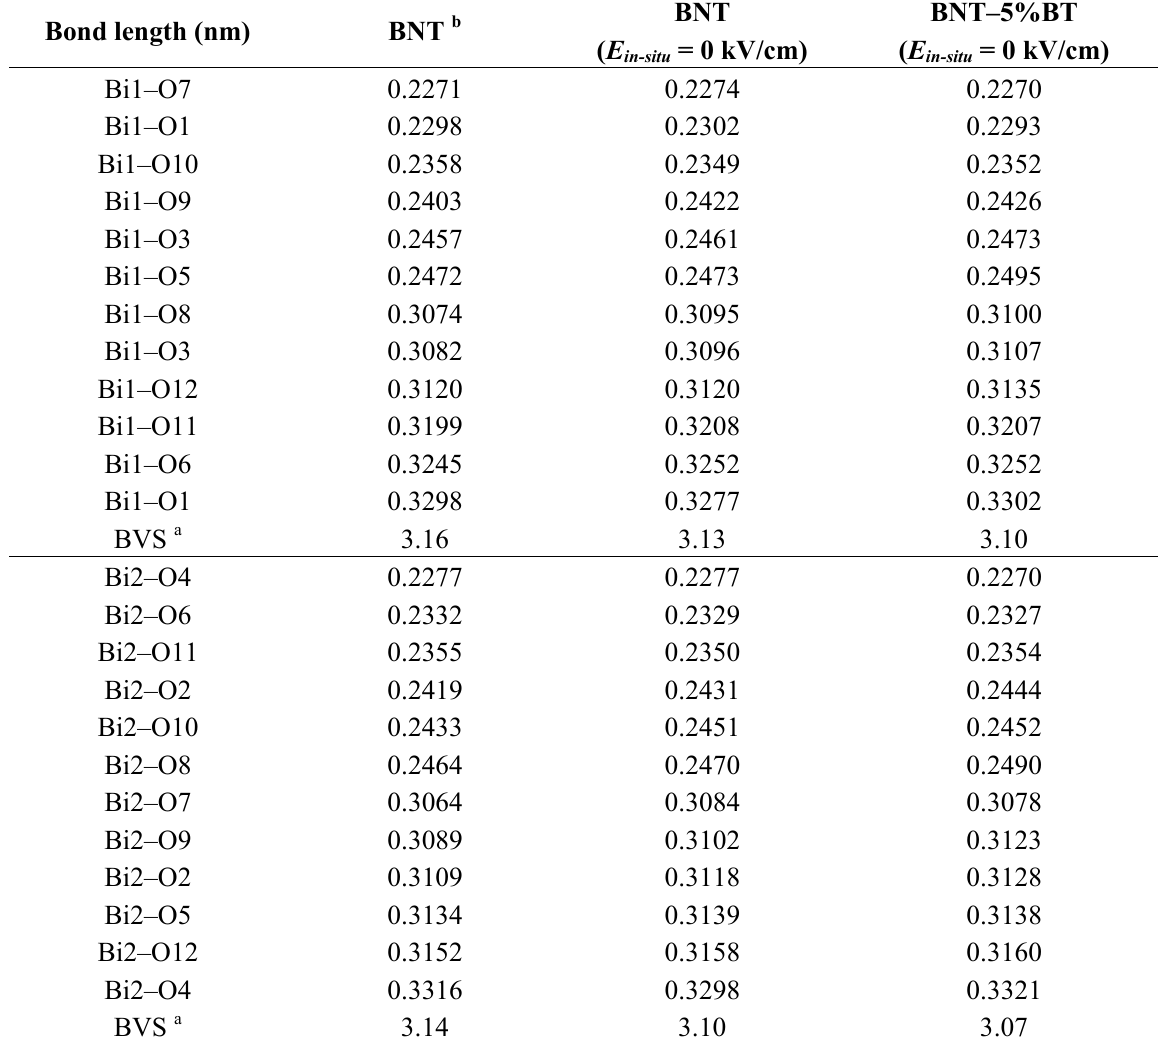
Table 2. Bond lengths of Bi–O obtained by the DFT calculations for BNT and BNT–5%BT with E = 0 kV/cm in the Pc in-situ